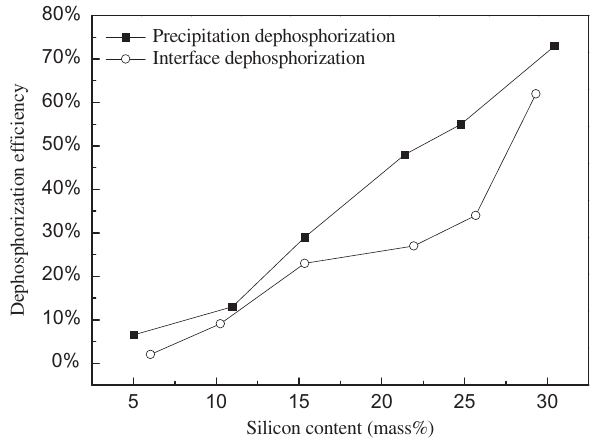
Figure 2: Relationship between de-P efficiency and silicon content of nickel – silicon ferroalloy with different reductive de-P